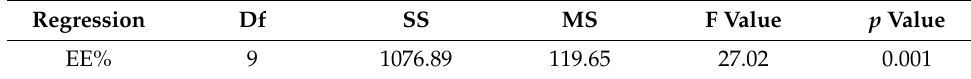
Table 13. ANOVA, DF, SS, MS, and F-Value for the EE% of the NPs.